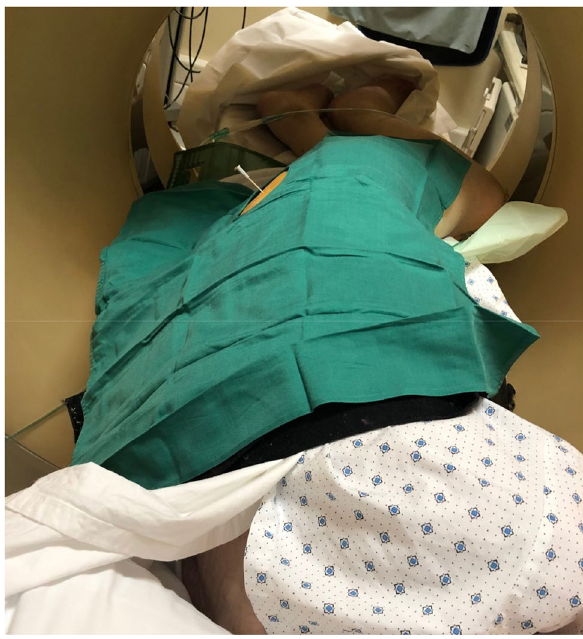
Fig. 3 Drainage under CT guidance through a transgluteal approach in the right lateral decubitus position